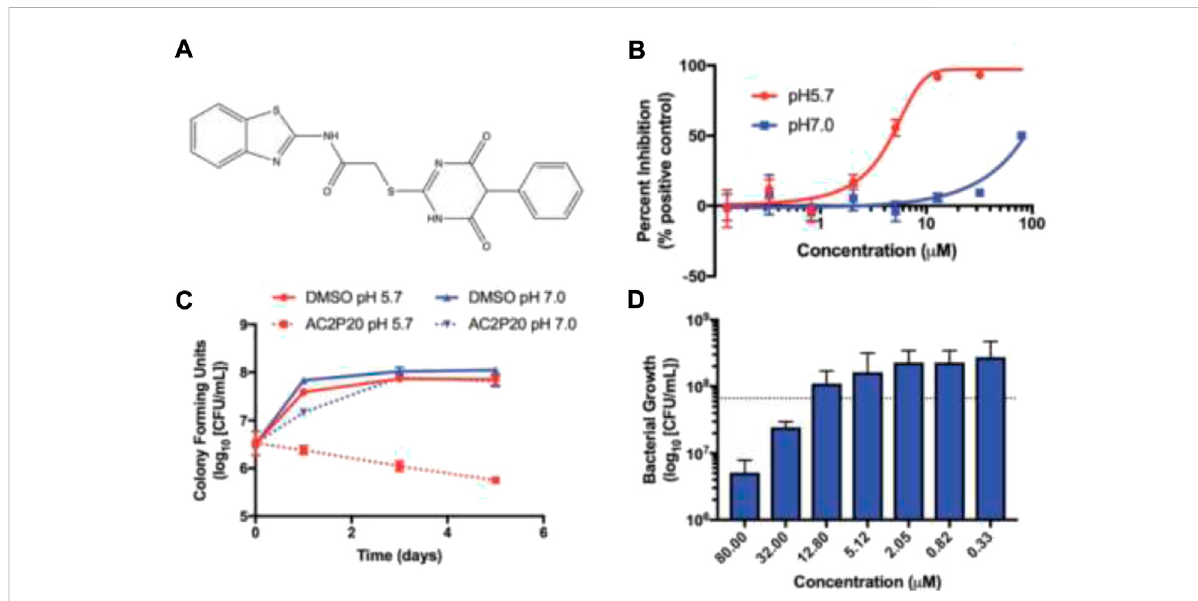
FIGURE 18 (A) Structure of AC2P20, (B) dose dependence of M. tb growth inhibition with the treatment of AC2P20 at 5.7 and 7.0 pH and exhibition of 4.3 μ